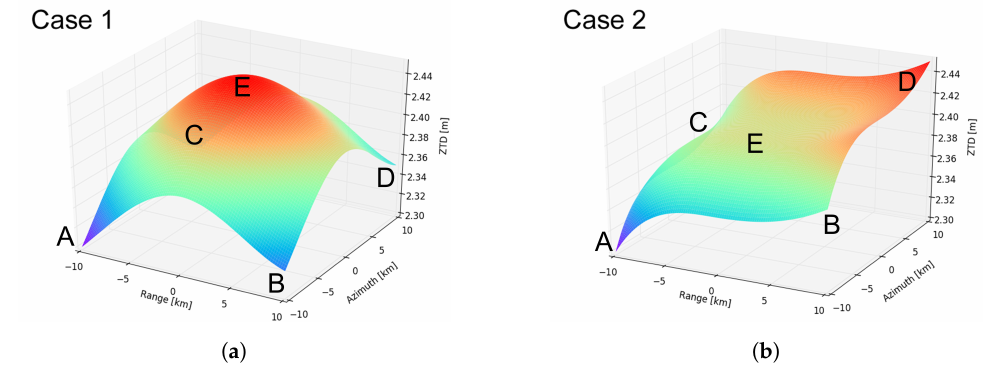
Figure 13. Two typical BTD errors for the GEO SAR imaging simulation. ( a ) Case 1: the main component is quadratic. ( b ) Case 2: the main component is